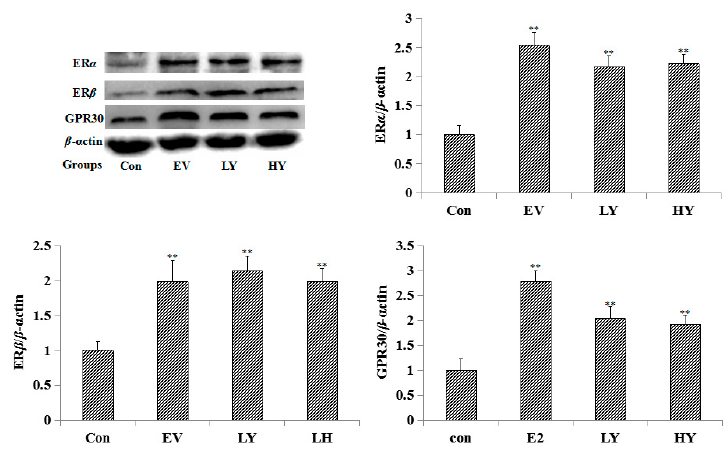
Figure 2. Blockade of ER and GPR30 completely abolished the proliferation of yam-stimulated MCF-7 cells ( n = 4). * p < 0.05; ** p < 0.01 compared to controls. ( a ) Effects of ICI182,780 on the proliferation of yam-stimulated MCF-7 cells. ( b ) Effects of MPP on the proliferation of yam-stimulated MCF-7 cells. ( c ) Effects of THC on the proliferation of yam-stimulated MCF-7 cells. ( d ) Effects of G-15 on the proliferation of yam-stimulated MCF-7